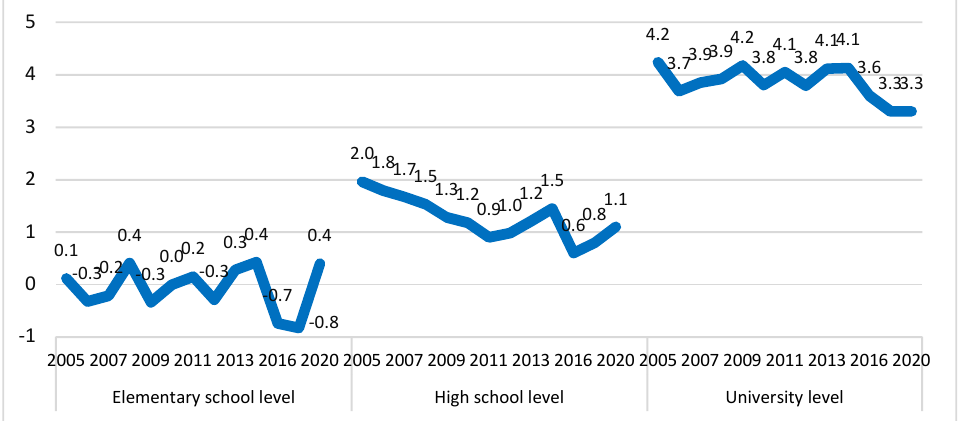
Figure 16. The General Diversity Index based on three weighted positive and three weighted negative statements about diversity—according to level of education.